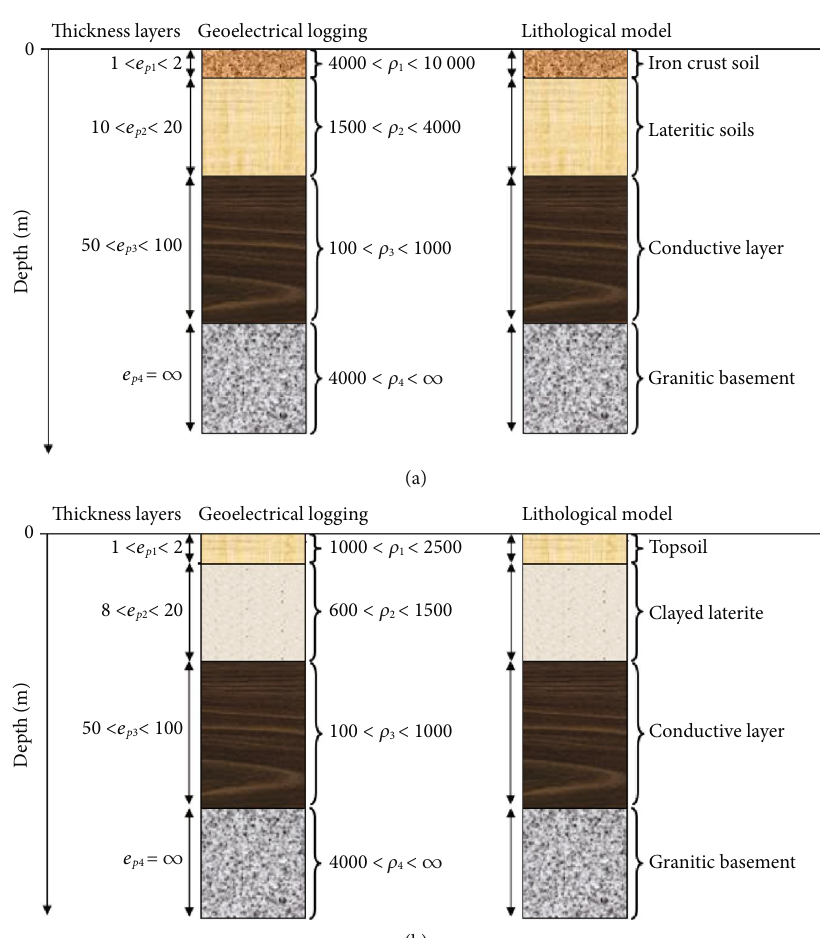
Figure 23: (a, b) Lithological models of sounding curves of type